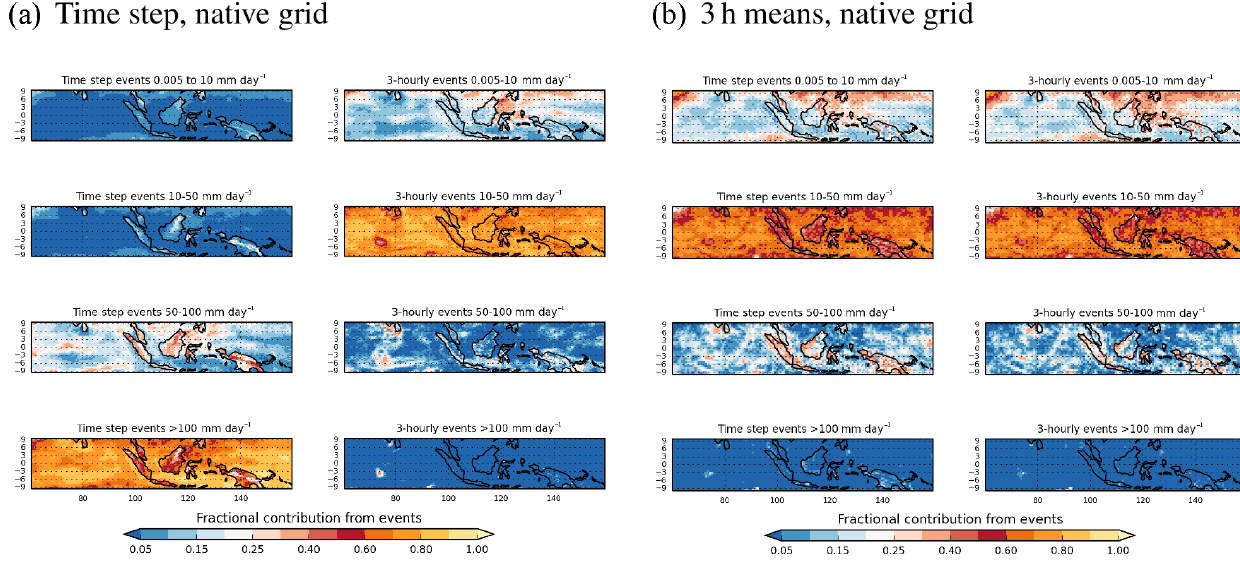
Figure 9. For (a) MetUM-GA3 and (b) ECEarth3, the fractional contributions to the average precipitation rate from ranges of intensity bins shown in the labels above each panel for (left column) time step data and (right column) 3h